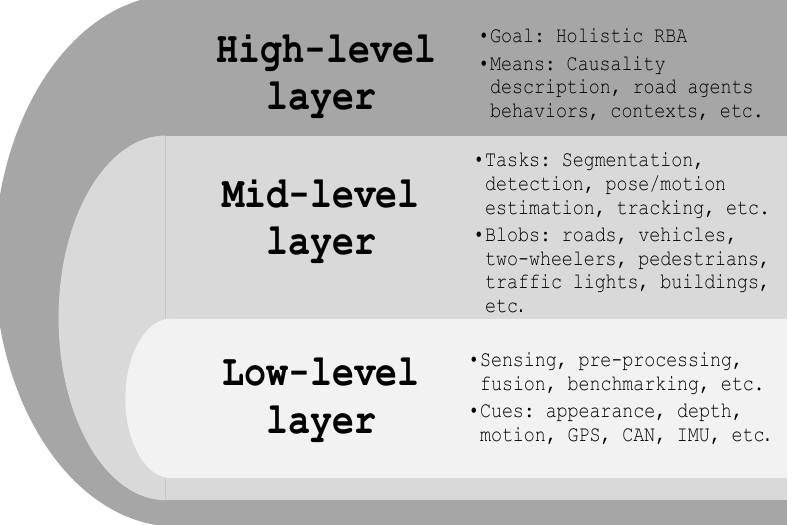
Figure 3. Illustrating the ascending levels of on-road behavior analysis. At the lowest layer, data such as appearance, depth, and motion are collected, pre-processed, and labeled to prepare the settings for higher layers’ tasks. One level up, several mid-level understanding scenarios might occur to describe and model spatial and/or temporal visual data like road agents detection, recognition, activities classification, maneuvers identifications, etc. At the highest level, an aggregate of the lower layers’ outcomes is used to learn the overall on-road behaviors by including more intuitive paradigms like causality. In this work, we focus on five high-level tasks, mainly situational awareness, driver-road interaction, road scene understanding, trajectories forecast, and driving status